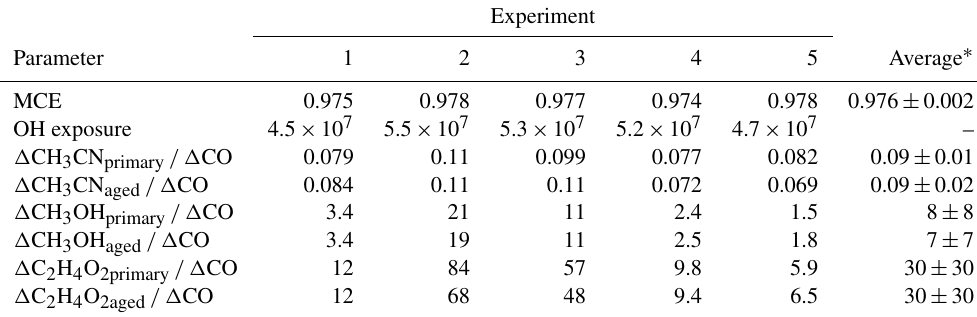
Table 1. Modified combustion efficiencies, OH exposures of reported aged values (moleccm − 3 h) and enhancement of select species relative to CO enhancement above background levels (pptvppbv − 1 )